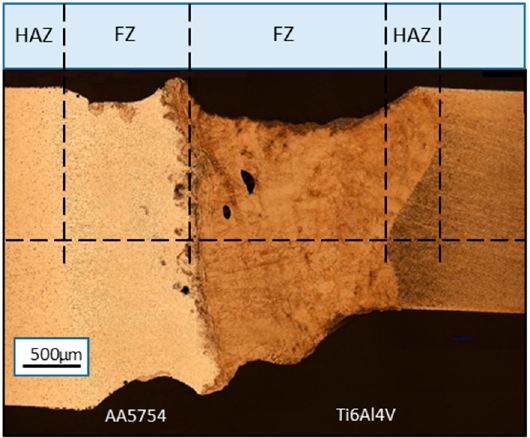
Figure 6. Appearance of Ti6Al4V/AA5754 laser welded joint after chemical etching.